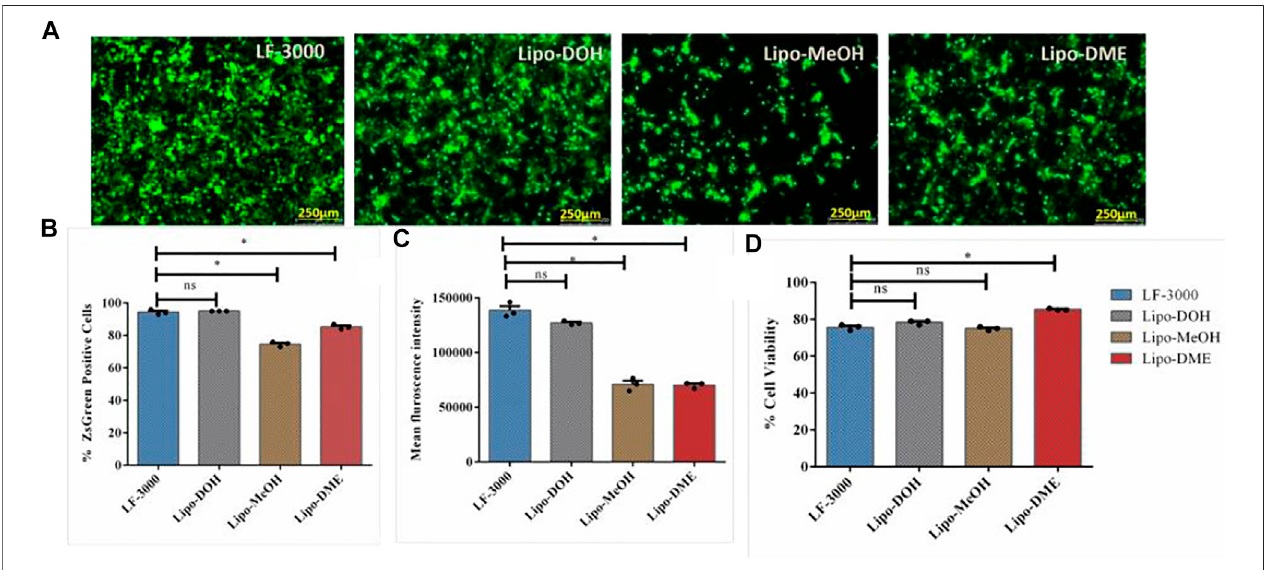
FIGURE 2 | Transfection ef fi ciency of liposomes. HEK-293T cells were transfected by pDNA (Lenti-Luciferase-IRES-ZsGreen) with indicated lipoplexes; the expression of ZsGreen proteins was imaged by using a fl uorescent microscope (A) , and we quanti fi ed percentage of ZsGreen positive cells (B) and MFI (C) by fl ow cytometry at 48 h post transfection. At 48 h post transfection, cells were trypsinized and stained with 7-AAD dye and estimated the cell viability by fl ow cytometry (D)